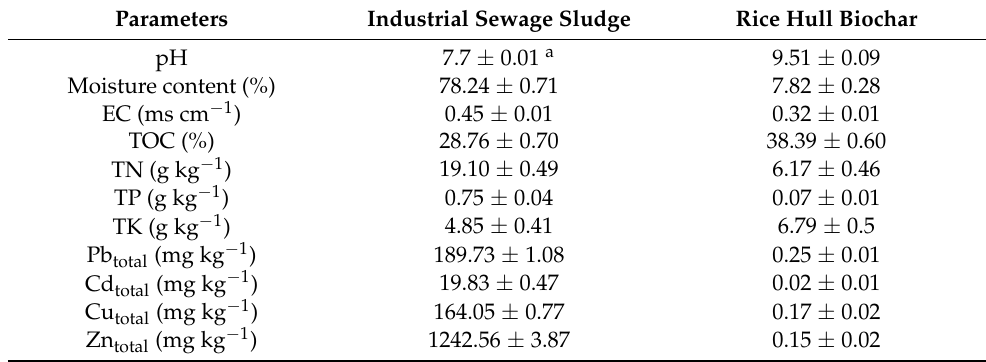
Table 2. Physicochemical properties of industrial biochar and sludge used for different